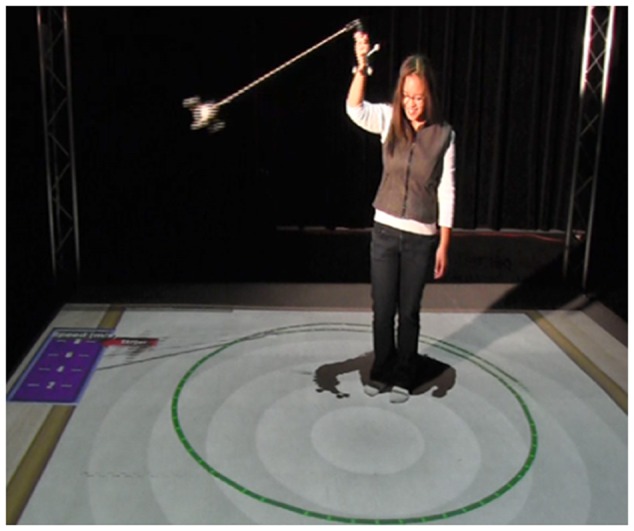
The “Swinger” in action. Note dynamic simulations projected on the floor giving real-time feedback.